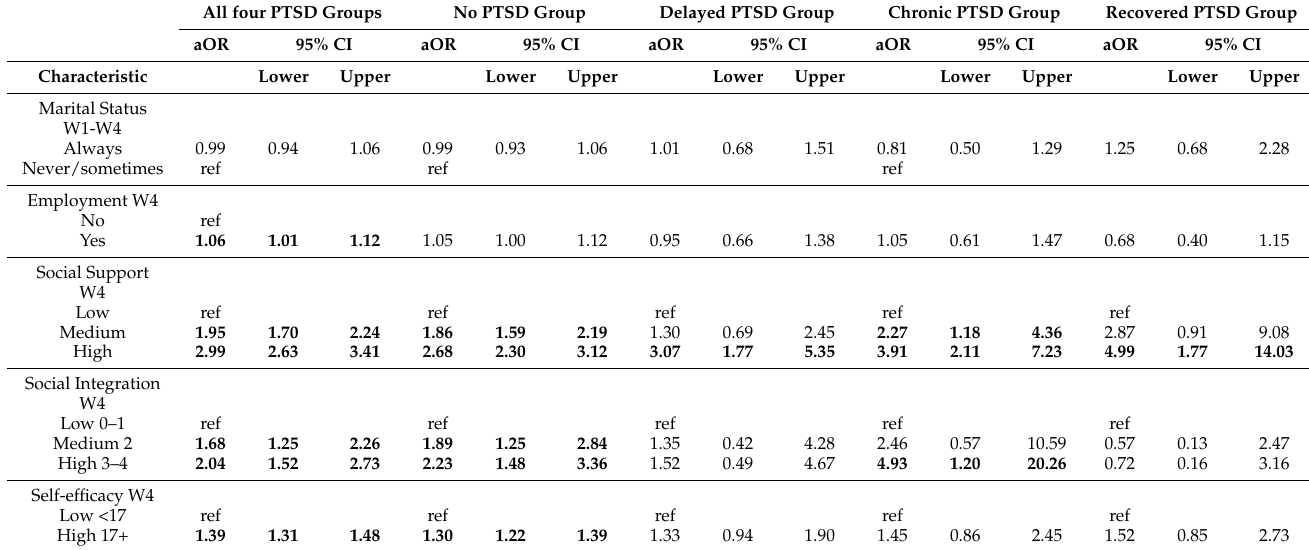
Table 2. Multivariable logistic regression results of the psycho-social factors with social embeddedness. All four PTSD